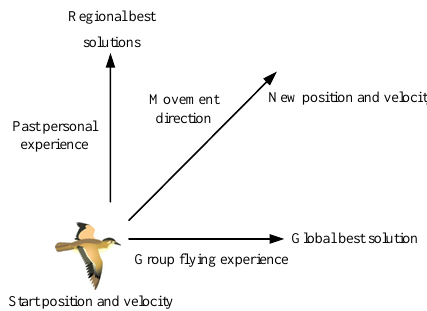
Figure 9. Principle of particle swarm motion.